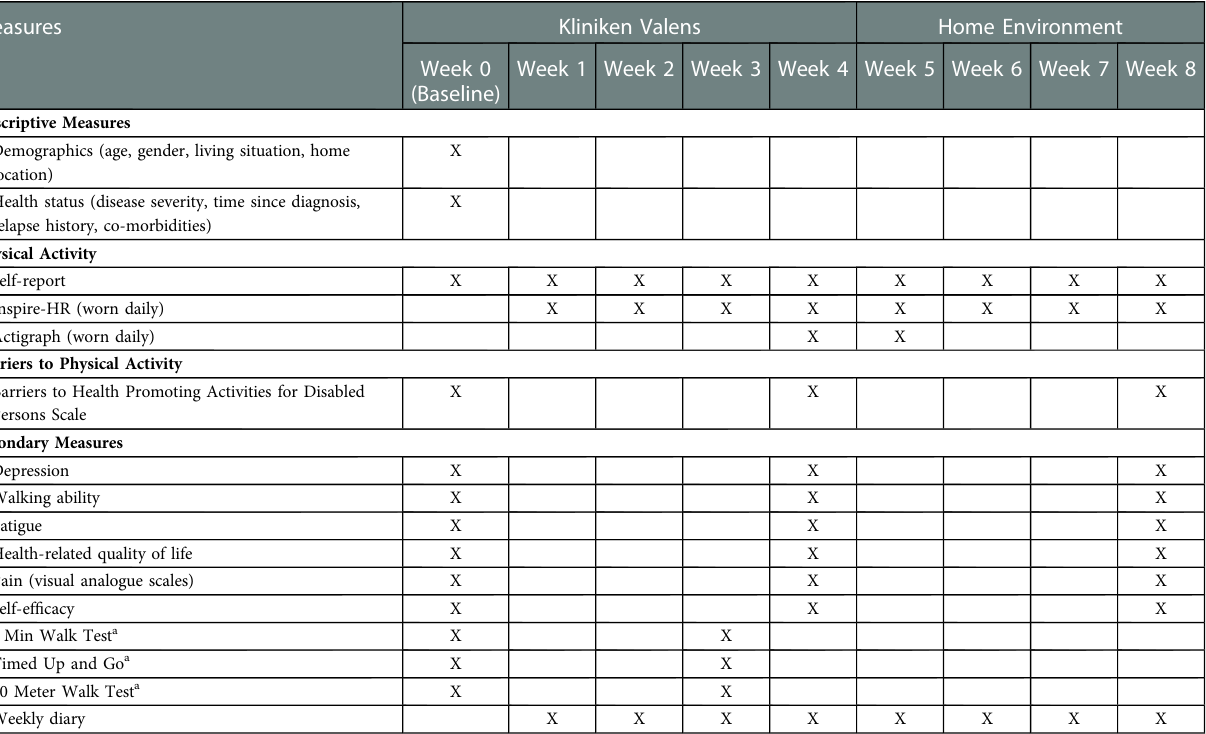
TABLE 1 Schedule of assessments throughout the BarKA-MS study. Measures